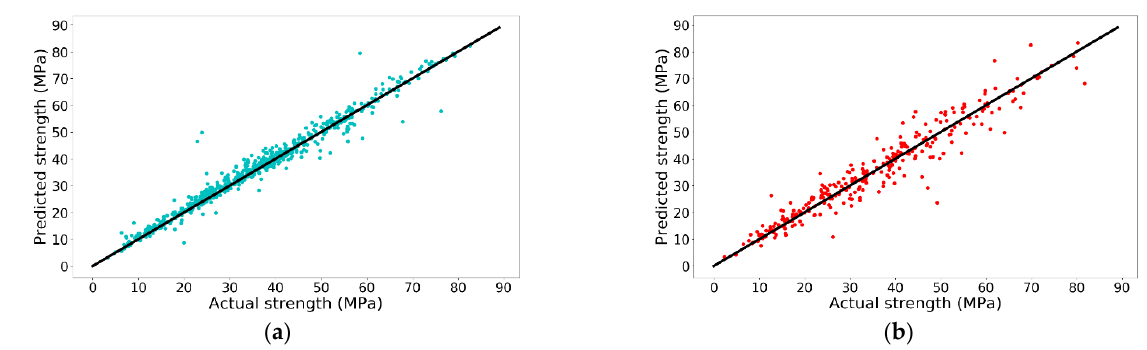
Figure 13. R-square of ANN with different learning rate.